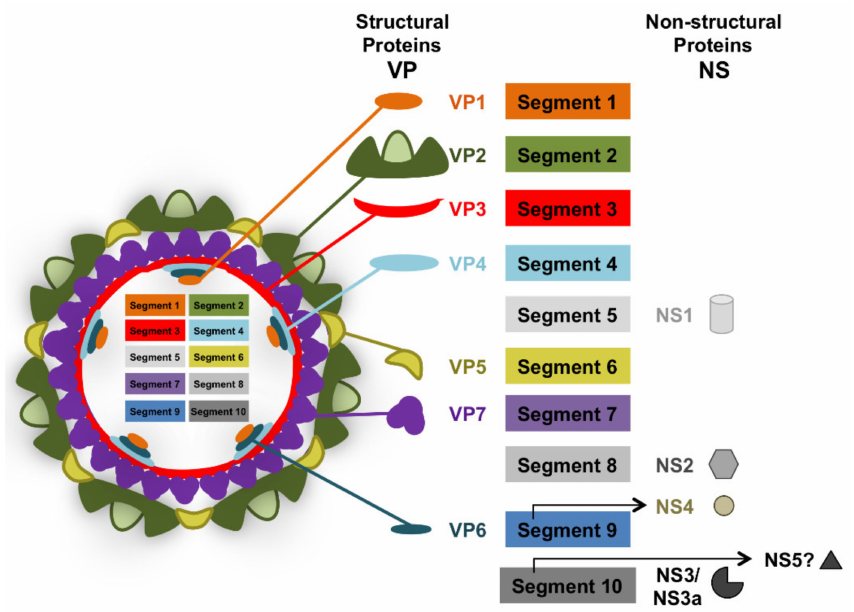
Figure 1. Schematic of bluetongue virus particle. BTV is a 10-segment dsRNA virus that belongs to the Reoviridae family. Its genetic material encodes for 7 structural proteins (VP) and 4–5 nonstructural proteins (NS). Segment 1 encodes for the RNA polymerase VP1. Segment 2 encodes for the highly variable outer capsid protein VP2. Segment 3 encodes for the inner core protein VP3. Segment 4 encodes for RNA capping enzyme and methyl transferase VP4. Segment 5 encodes for the nonstruc- tural protein NS1 which forms cytoplasmic tubules during infection. Segment 6 encodes for the outer capsid protein VP5. Segment 7 encodes for the inner core protein VP7. Segment 8 encodes for the nonstructural protein NS2 which is part of the viral inclusion bodies. Segment 9 encodes for the RNA helicase VP6 and the non-structural protein NS4 which interferes with host immune response. Segment 10 encodes for the non-structural protein NS3 and its isoform NS3a which is involved in virion egress but also acts as an IFN antagonist. Segment 10 also putatively encodes for a fifth non-structural protein (NS5) that could be involved in host cellular